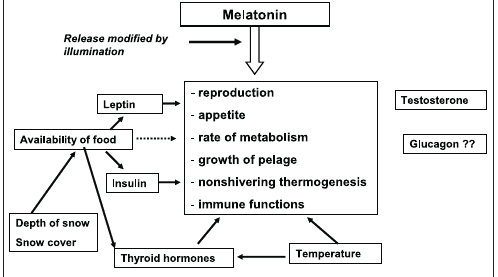
Fig. 3. Release of melatonin from the pineal gland is regulated by photoperiod, and the physiological effects of the melatonin are modified by several other hormones the concentrations of which also show seasonal